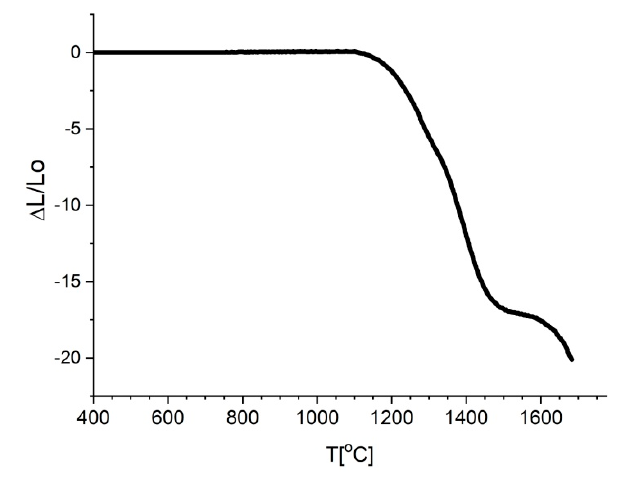
+ 6%Al + 4%Y 3 N 4 2 O 3 2 O 3